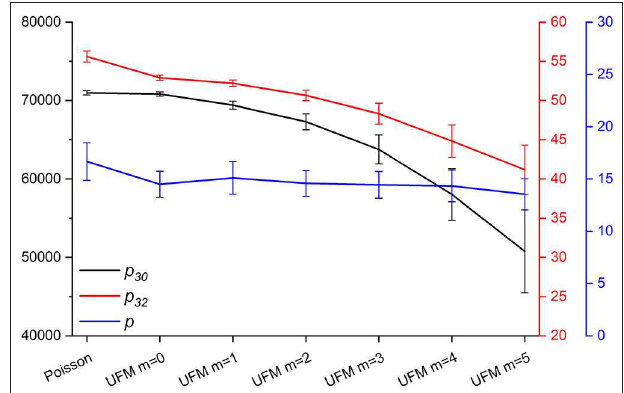
FIGURE 3 | Fracture density statistics of generated networks in cubic systems of volume V = 1 .